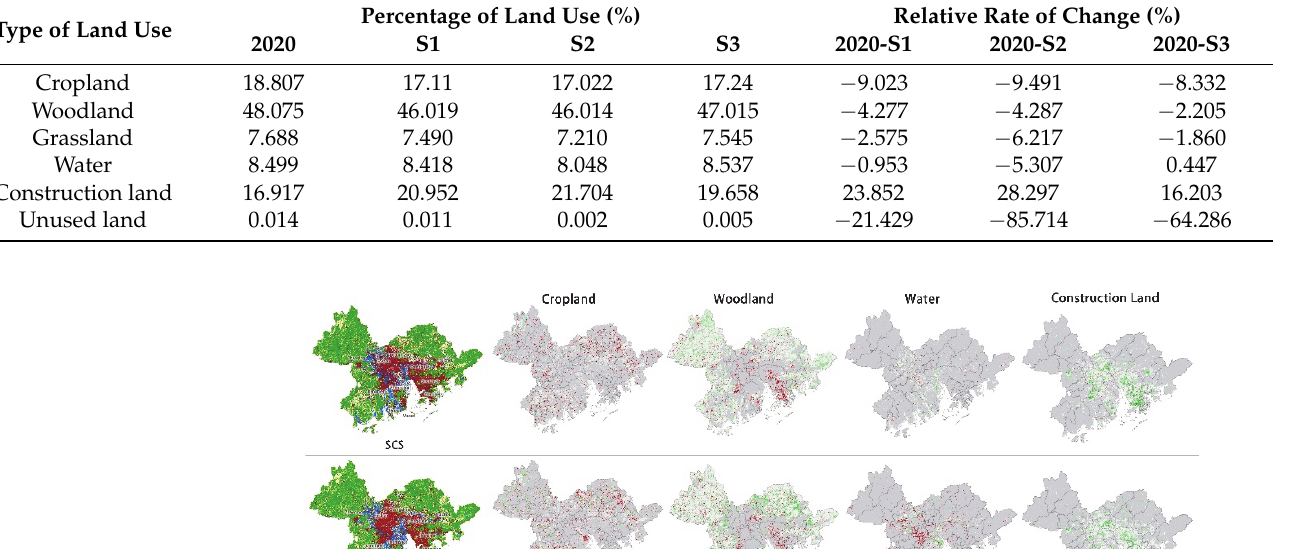
Table 4. Land use area and relative change rate under multiple scenarios from 2020 to 2035.